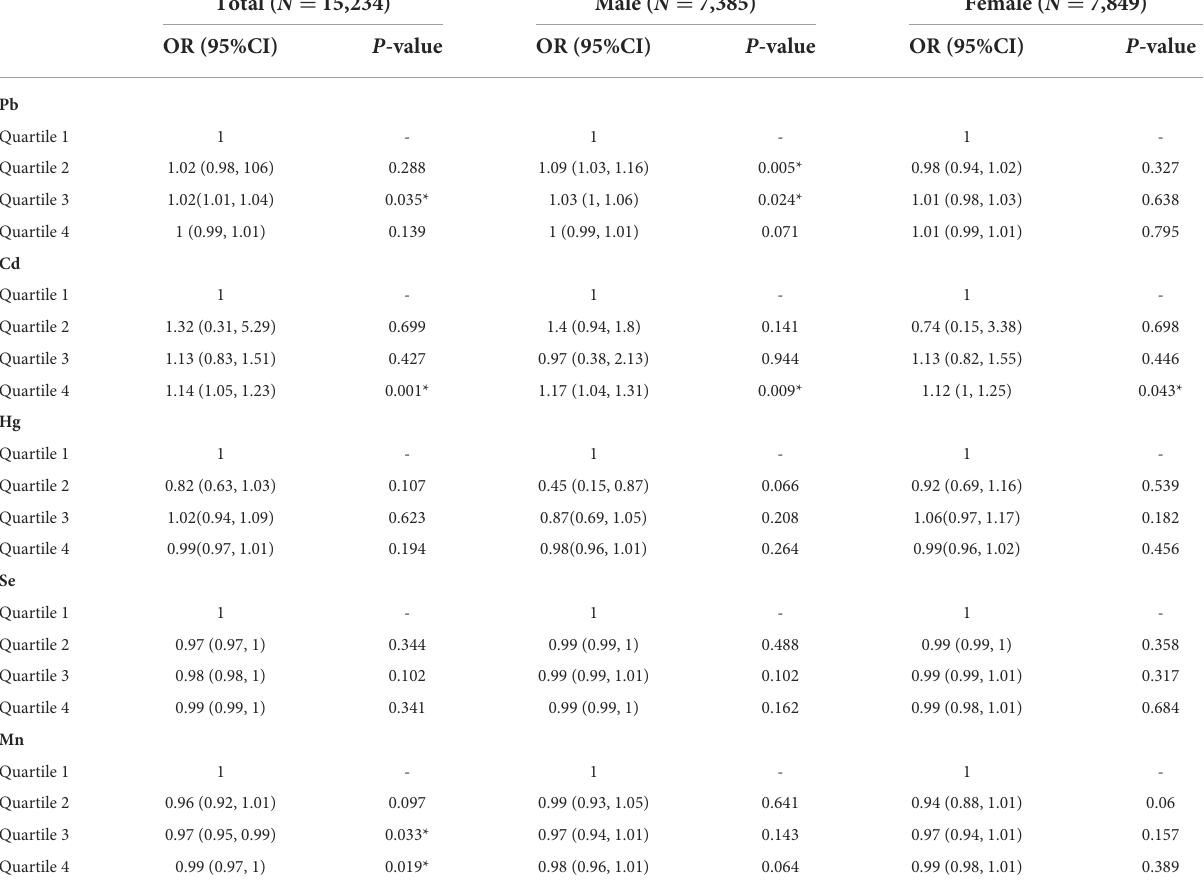
TABLE 3 Association between blood metals (ug/L) and osteoarthritis in elderly American subject with gender subgroups, from NHANES